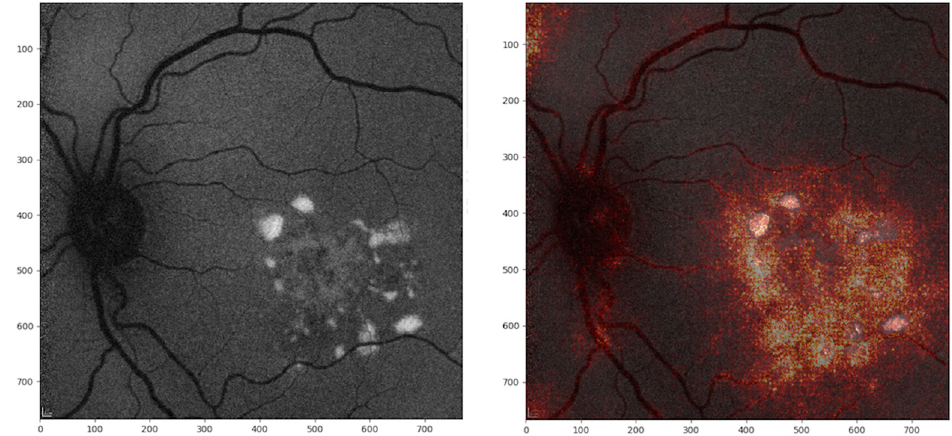
Figure 4. Fundus autofluorescence (FAF) image (left panel) with integrated gradient visualization of incorrect attribution (right panel) in a case of Stargardt disease: the hyperautofluorescent flecks present in the central macular region have determined a predicted diagnosis of Best disease by the deep learning model.